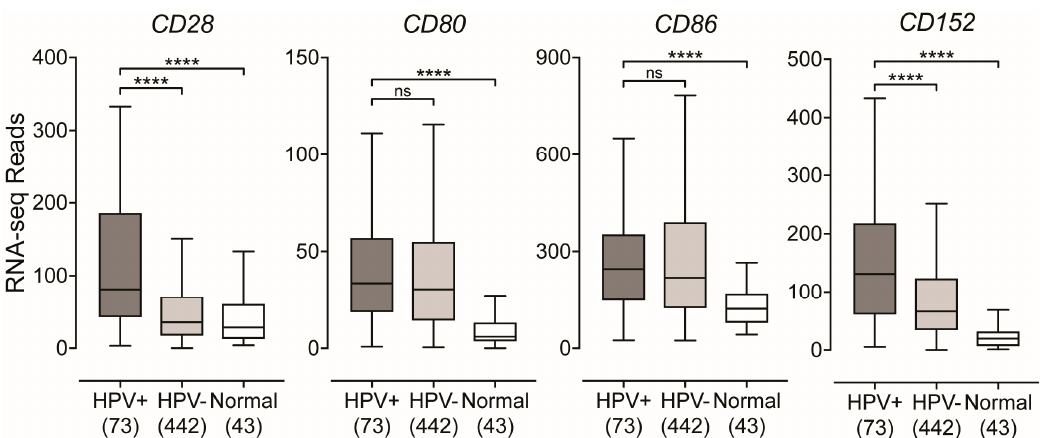
Figure 5. Expression of genes that encode for T-cell co-stimulatory molecules in head and neck carcinomas stratified by HPV-status. RSEM normalized RNA-seq data for genes that encode T-cell specific co-stimulatory molecules was extracted from the TCGA database for the HNSC cohort for HPV + , HPV − , and normal control tissues. Statistical analysis was performed using a two-tailed non-parametric Mann–Whitney U test. Numbers in brackets refer to the number of samples included in each analysis. * p ≤ 0.05, ** p ≤ 0.01, *** p ≤ 0.001, **** p ≤ 0.0001, ns—not significant.